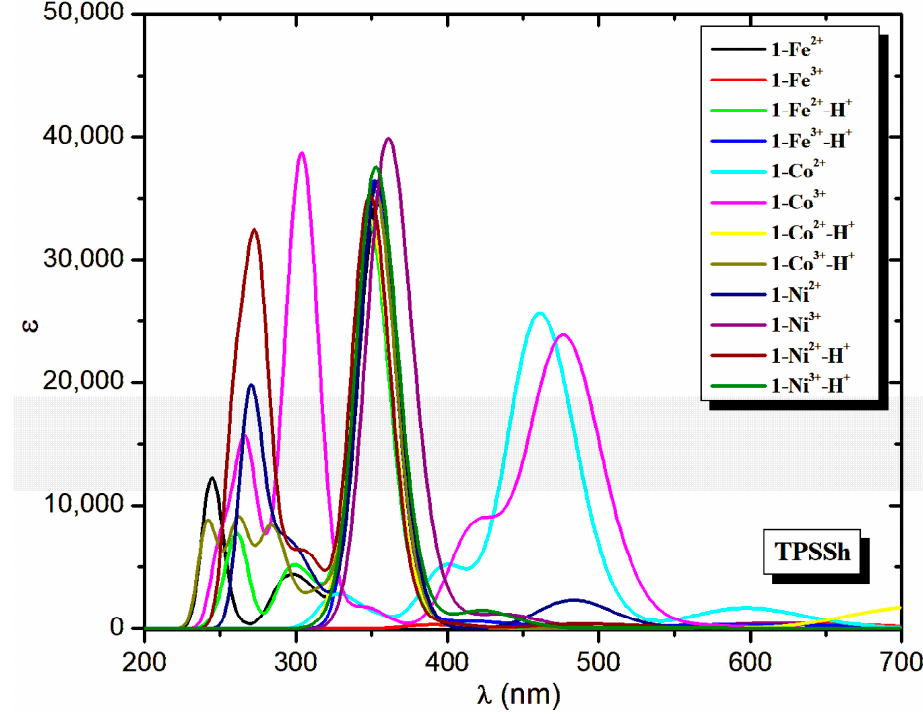
Figure 3. Absorption spectra of the calculated minima at TPSSh/6-31G(d,p) in THF solvent.